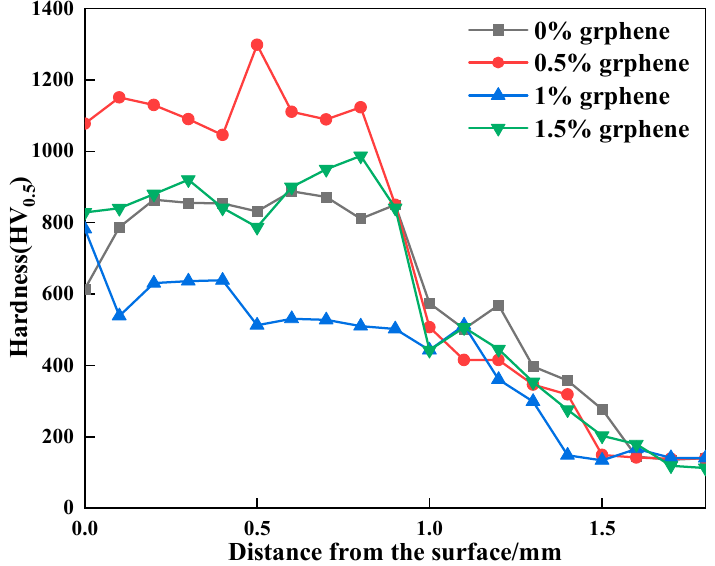
Figure 9. The hardness curves of the clad layer with different additions of graphene.